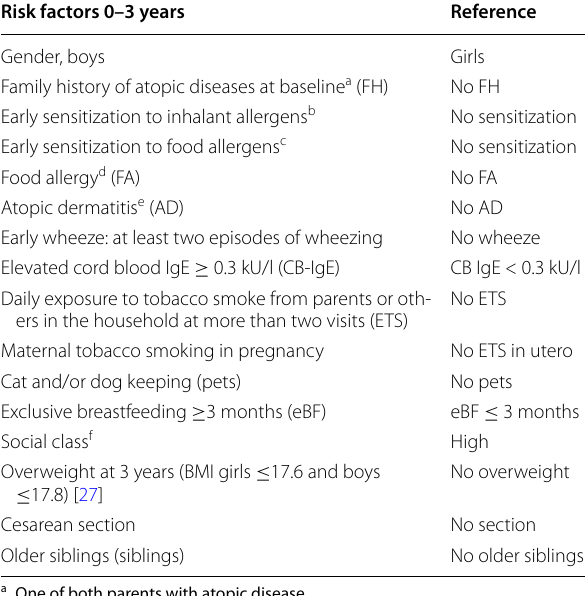
Table 1 Potential risk factors for rhinoconjunctivitis (RC), allergic RC and non-allergic RC, at 14